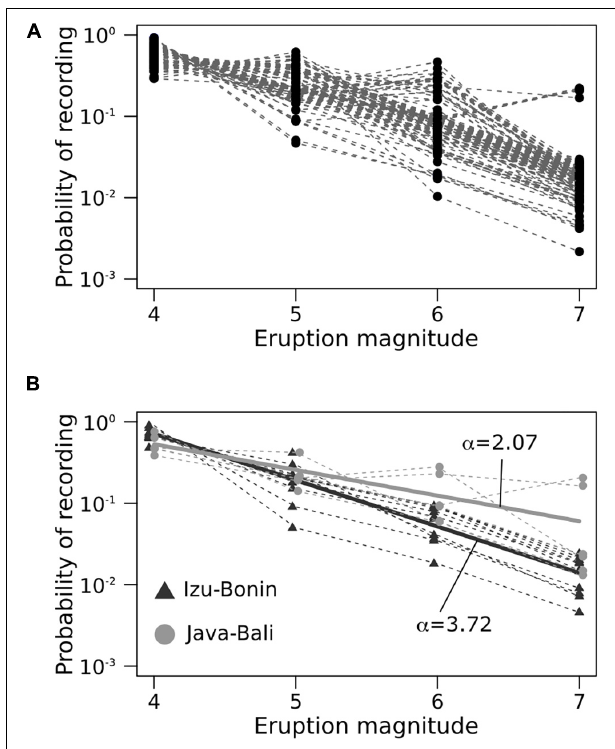
FIGURE 5 | Probability of recording different eruption magnitudes for; (A) all 162 volcanoes in our analysis; (B) Izu-Bonin and Java-Bali (dashed-lines), with the average distribution for each arc fitted using a power law (solid lines). The slope of the power-law is characterized by the α parameter.